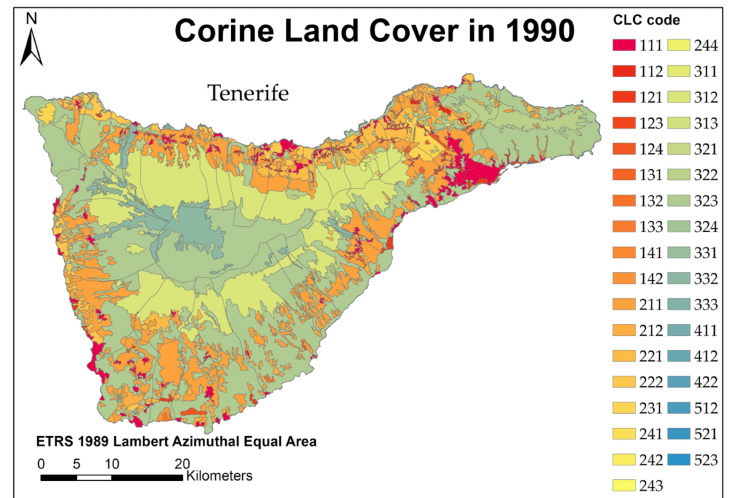
Figure 15. Thematic cartography regarding the land-use changes in the Canary Archipelago in the year 1990.